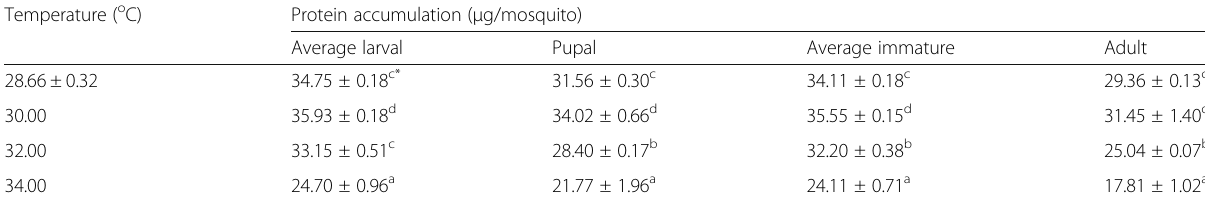
*Within a column, means (±SD) followed by small letter are not significantly different at p <0.05 according to Duncan multiple range test following analysis of variance